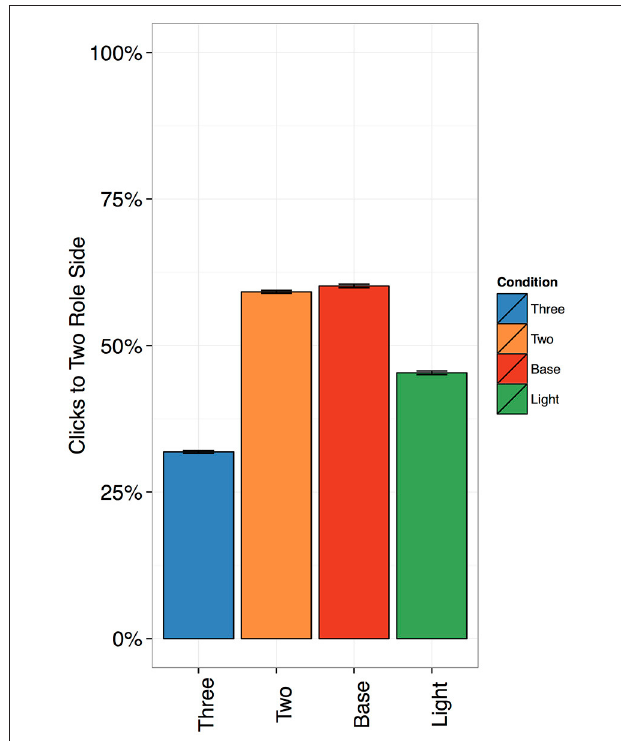
FIGURE 2 | Percentage of clicks to the two-role side, with Standard Errors. The differences between two- and three-role sentences were significant, and so were the difference between light and two-role sentences and light and three-role